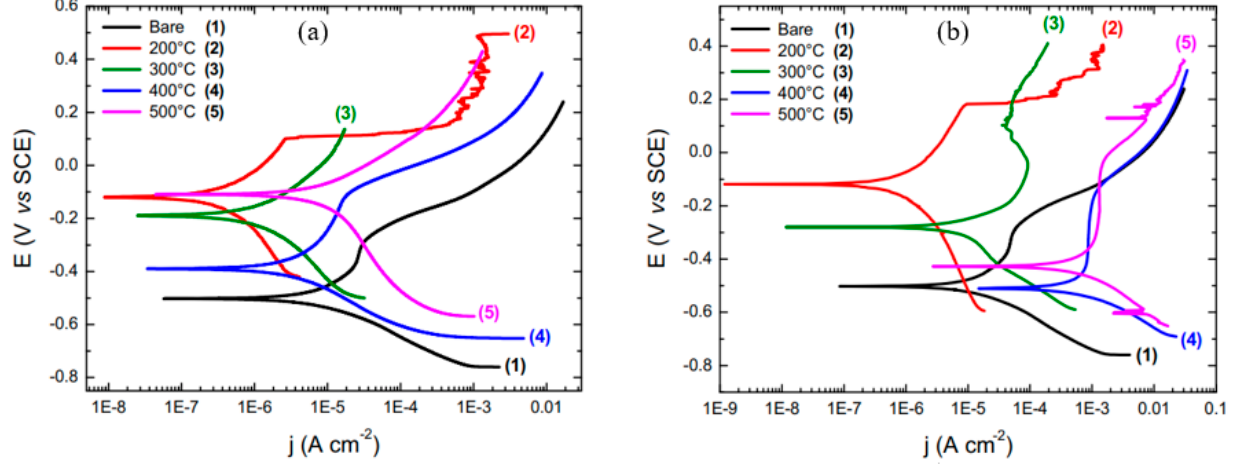
Figure 8. PDP curves in aqueous solution of NaCl 3.5% for electrodes coated with: ( a ) ceric ammo- nium nitrate and ( b ) cerium chloride, calcined at different temperatures and with heating rate of 5 °C/min [76].